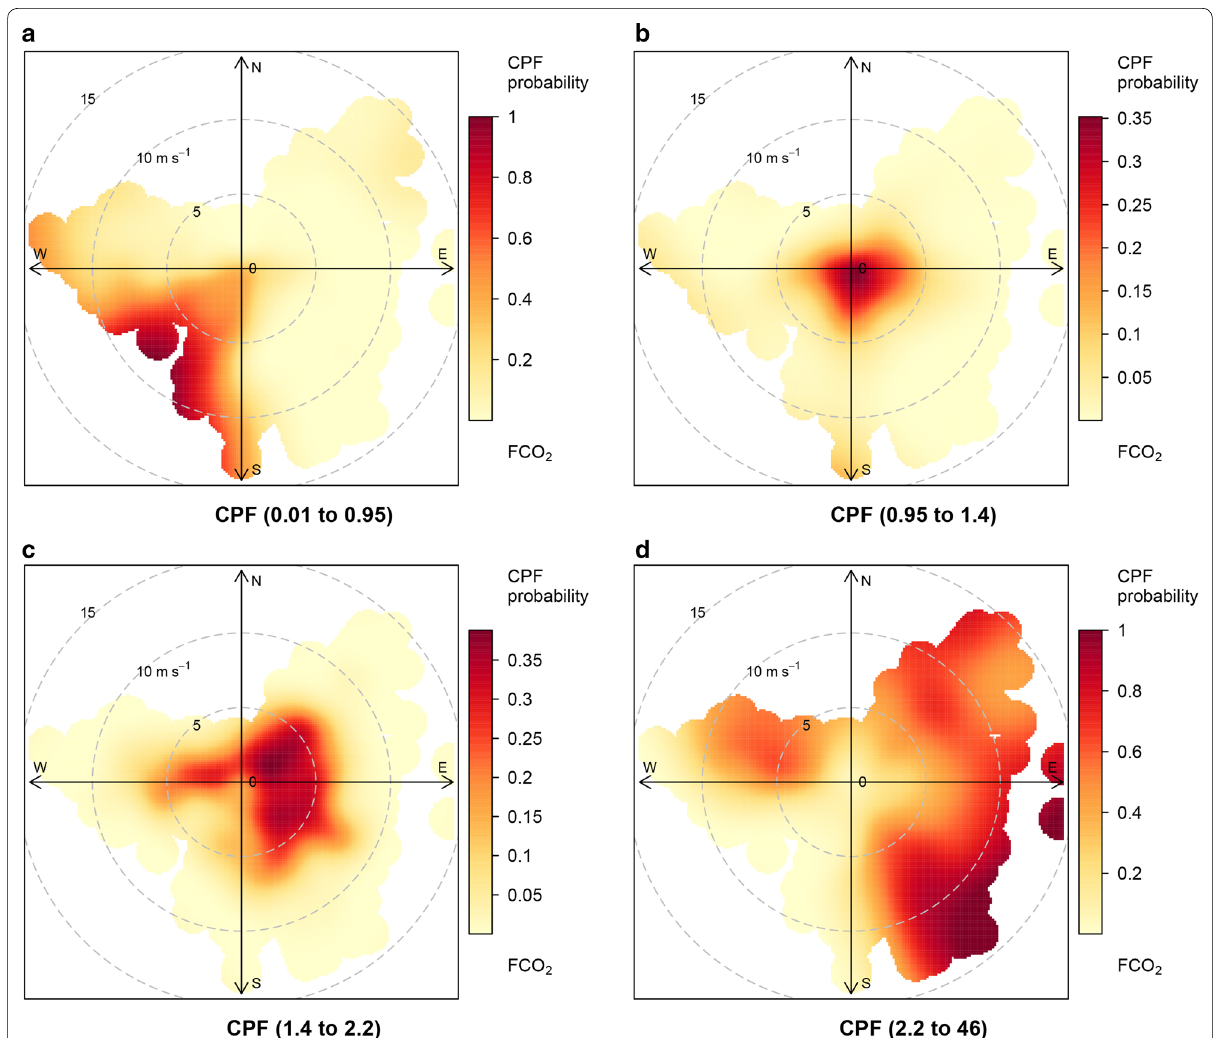
Fig. 6 Polar plots of conditional probabilities of soil CO 2 flux against wind speed and direction. Soil CO 2 fluxes are classified into the a first, b second, c third, and d fourth